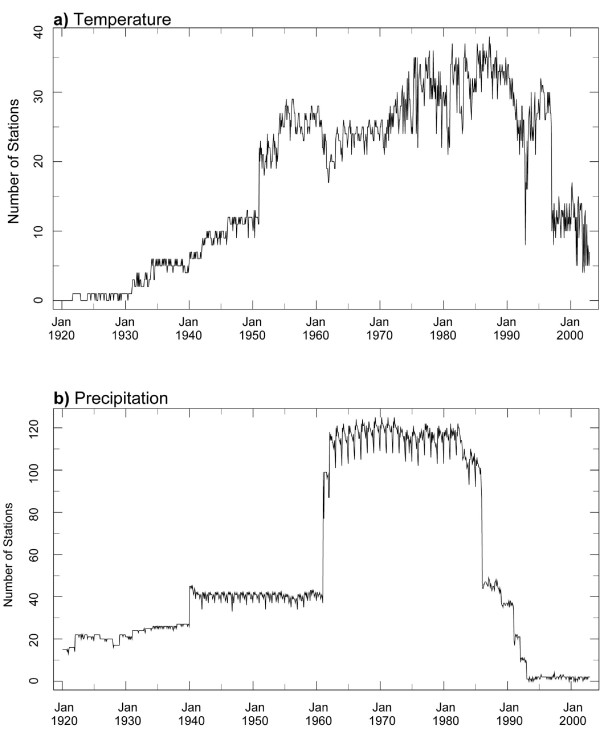
Number of stations reporting temperature observations (a) and rainfall observations (b) in UEA CRU v2.1 that are within the "radius of influence" of the grid point closest to the Kericho station. Monthly values, 1920-2002.